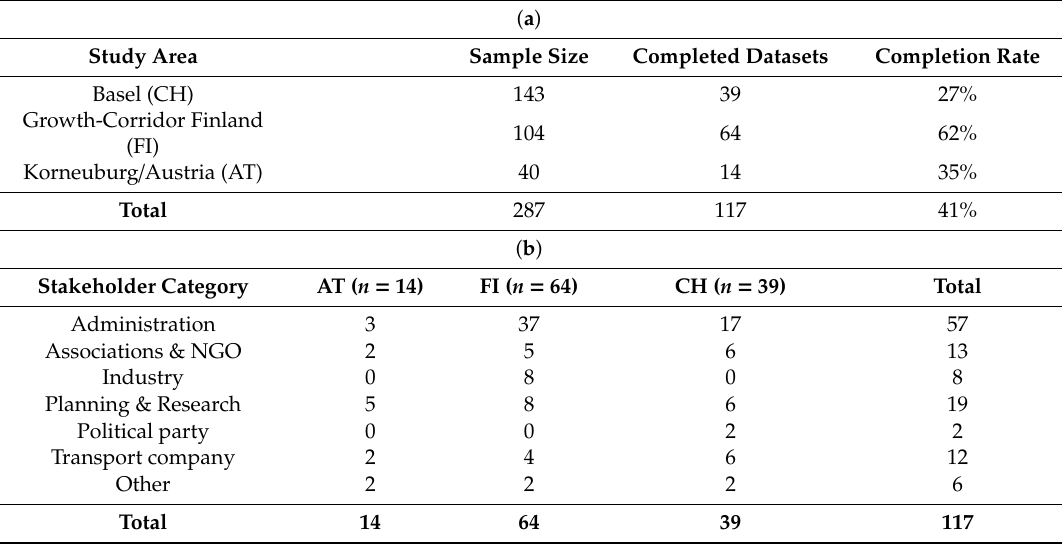
Table 1. ( a ) Return rates, sample sizes and ( b ) stakeholder category of the stakeholder survey. ( a ) Study Area Sample